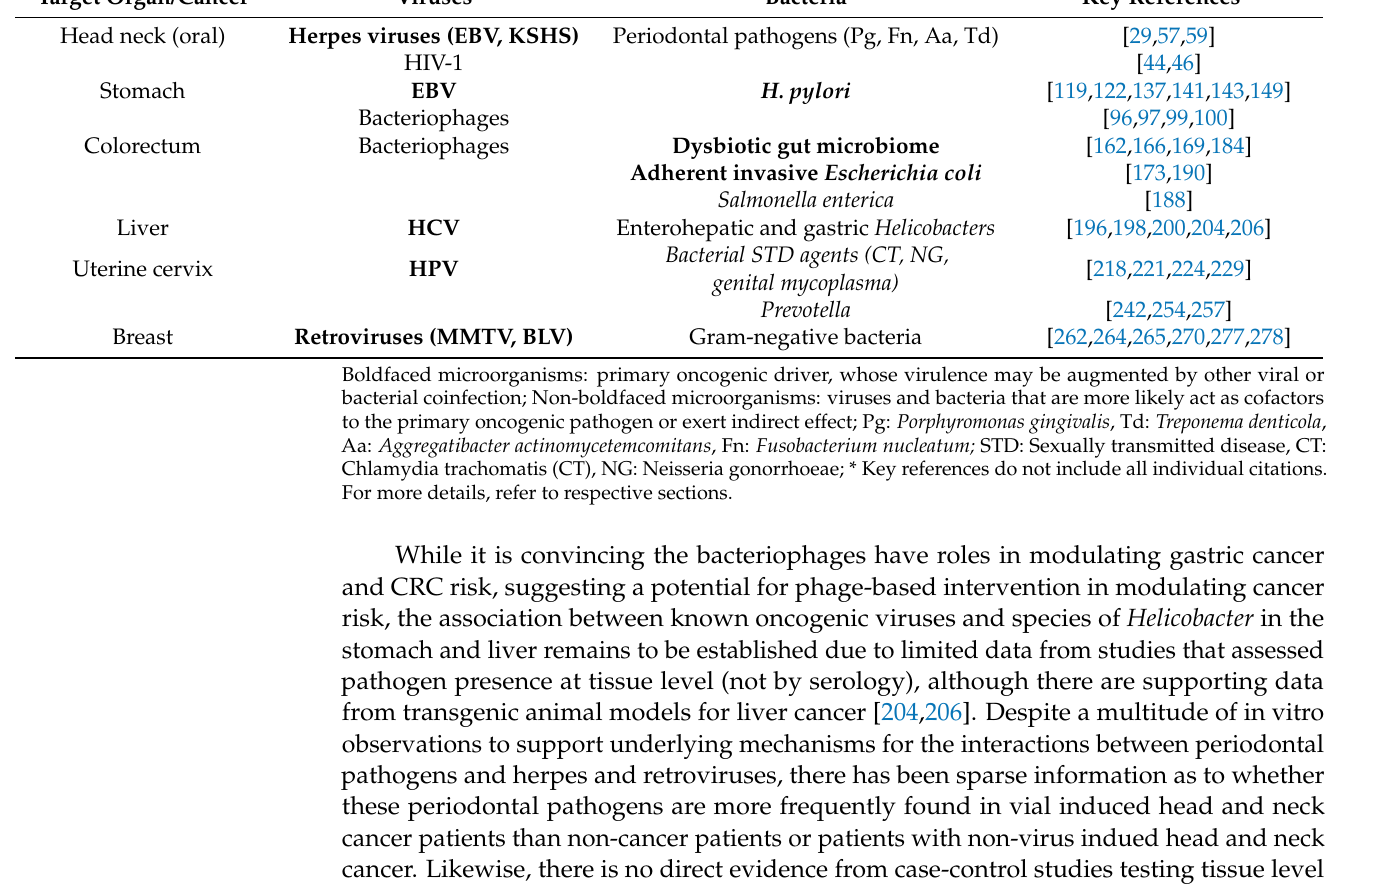
Table 1. Summary of bacterial and viral pathogens that may be jointly involved in the development of human orodigestive and female genital tract cancers. Target Organ/Cancer Viruses